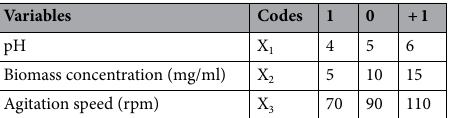
Table 6. Box-Behnken significant variables for Cr 6+ biosorption by actinomycete isolate.